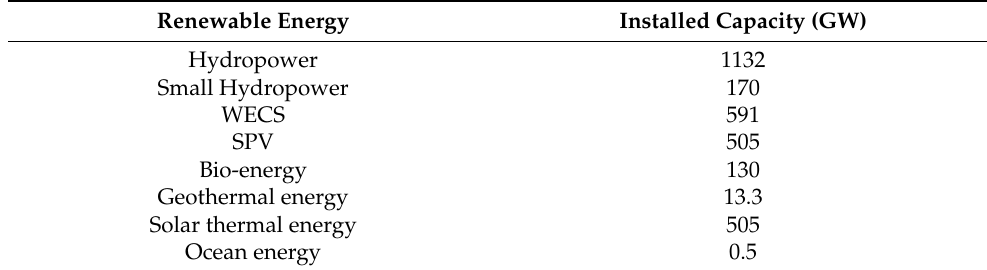
Table 1. Installed capacity in GW worldwide until 2019